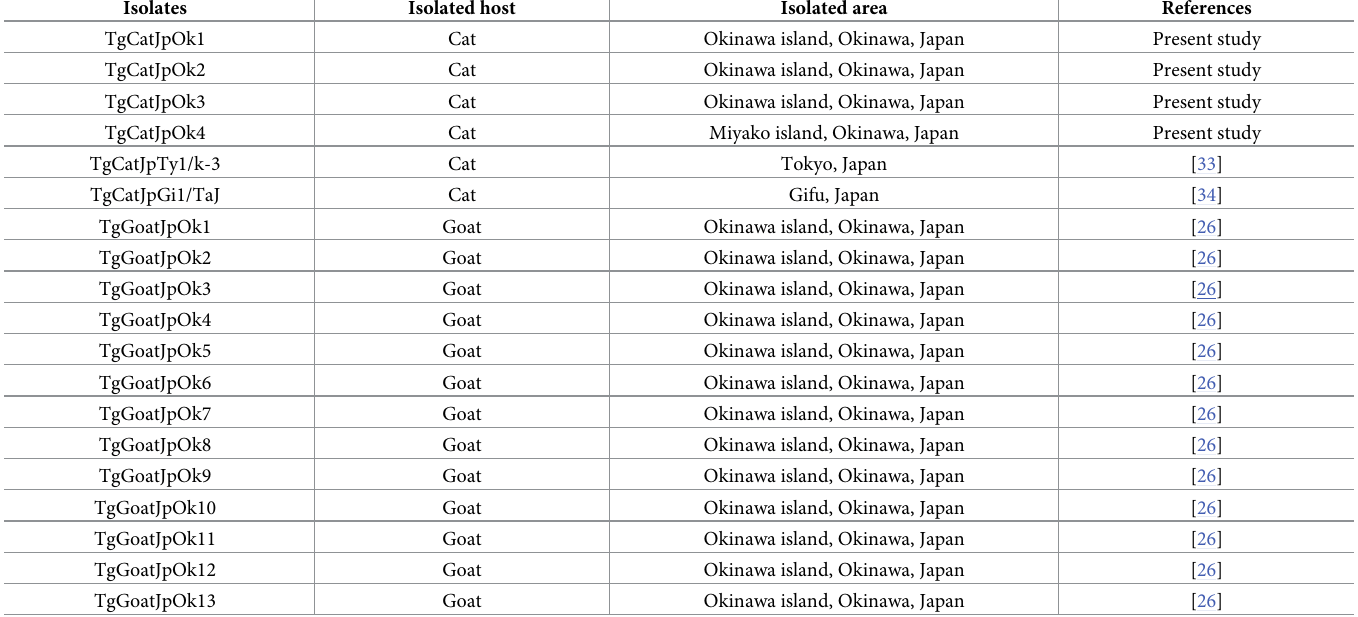
Table 1. Japanese isolates used in this study. Isolates Isolated